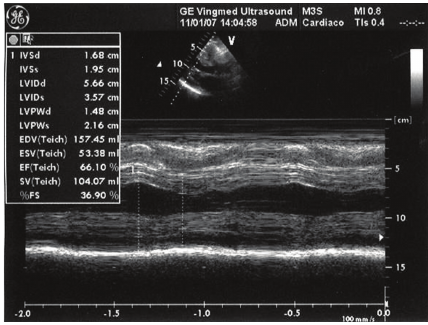
Figure 2: Case 1; echocardiography after bortezomib.